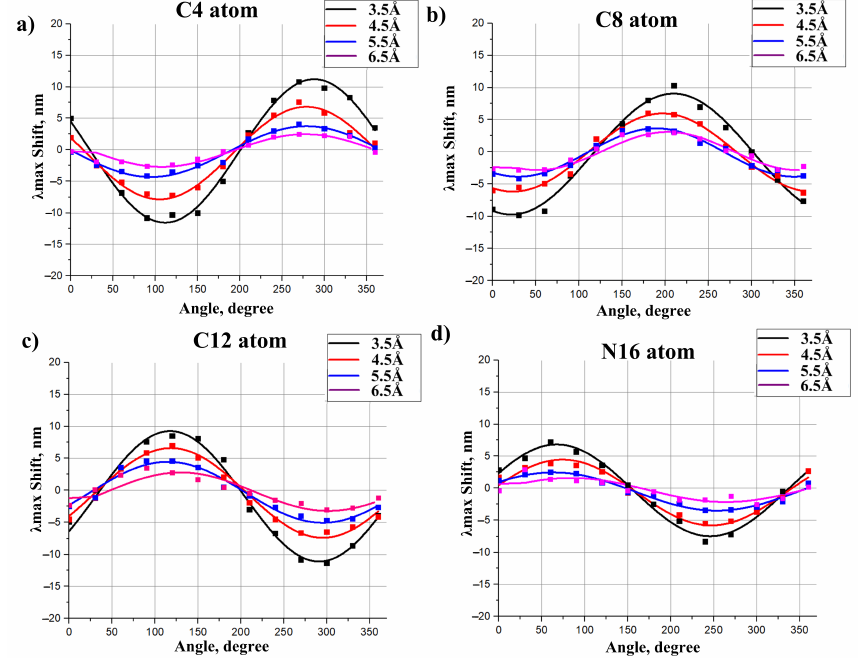
Figure 6. Impact of the dipole moment on λ max of the all-trans PSB as a function of the angle between the dipole and the chromophore axis. Functions were calculated for different positions of the dipole relative to the chromophore. Dipoles were located at the distances 3.5 Å, 4.5 Å, 5.5 Å, 6.5 Å from the C 4 ( a ), C 8 ( b ), C 12 ( c ), and N 16 ( d ) chromophore atoms along the grid line perpendicular to the chromophore axis (see Figure 4). Dots represent the ab initio calculated values. Functions were derived as the spline interpolation of the calculated data.